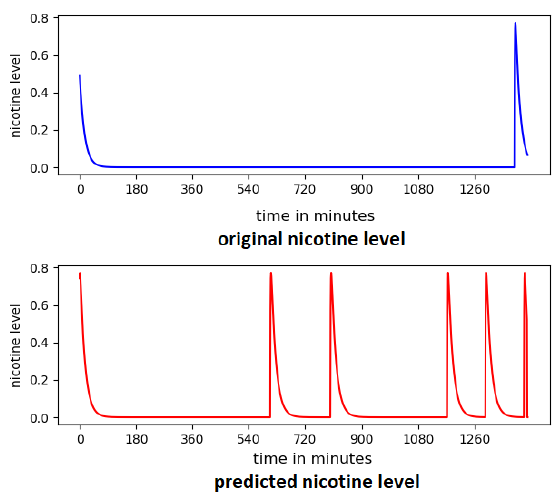
Figure 14. Predicted nicotine level for one day from participant 3 with no reported smoking